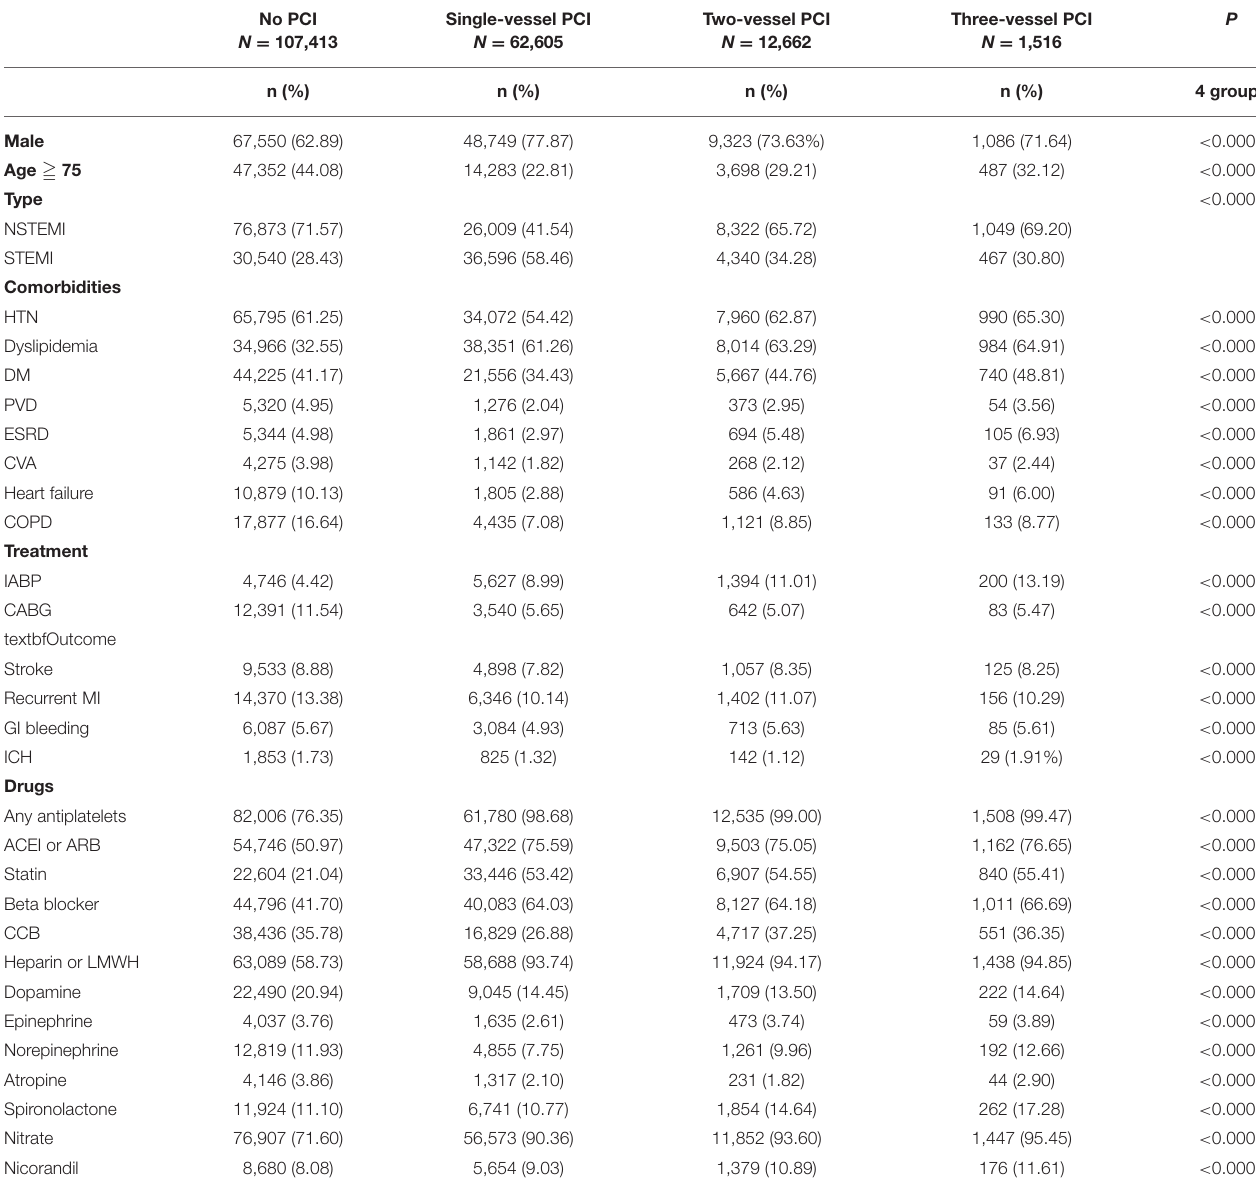
TABLE 1 | Characteristics of hospitalized patients with first AMI, managed with different PCI